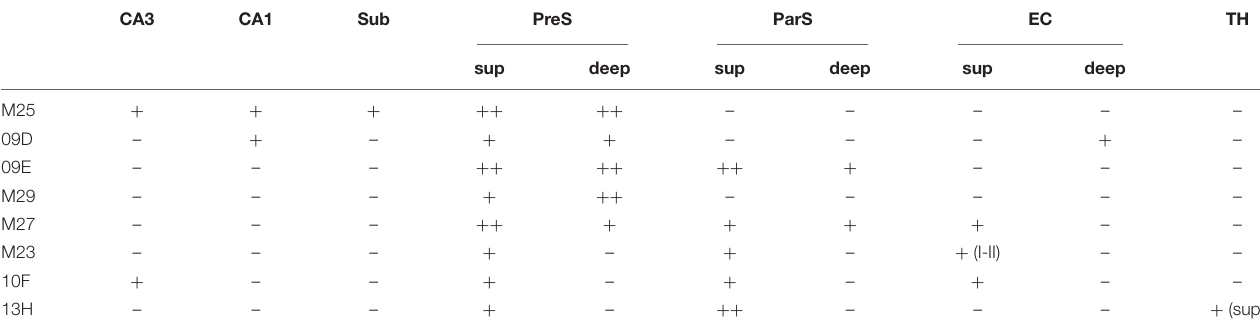
TABLE 3 | CTB injection sites and relative amount of tracer taken up in the hippocampal and parahippocampal areas of each experimental case.